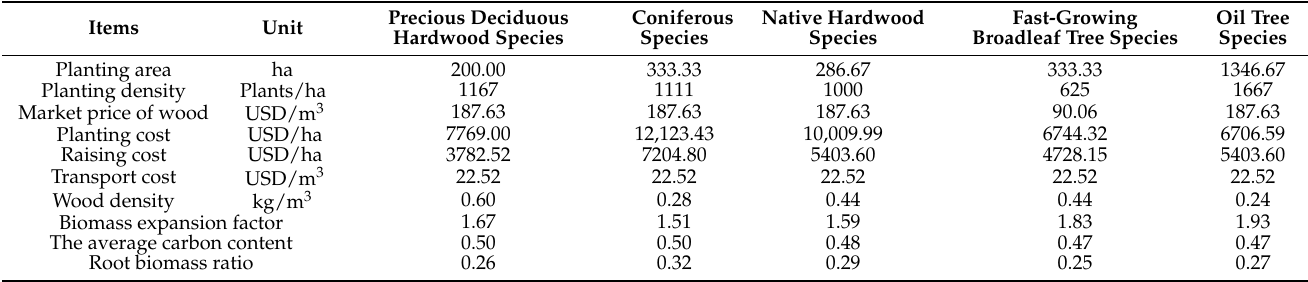
Table 1. The detailed data of five tree species in Laohekou NAP required by the